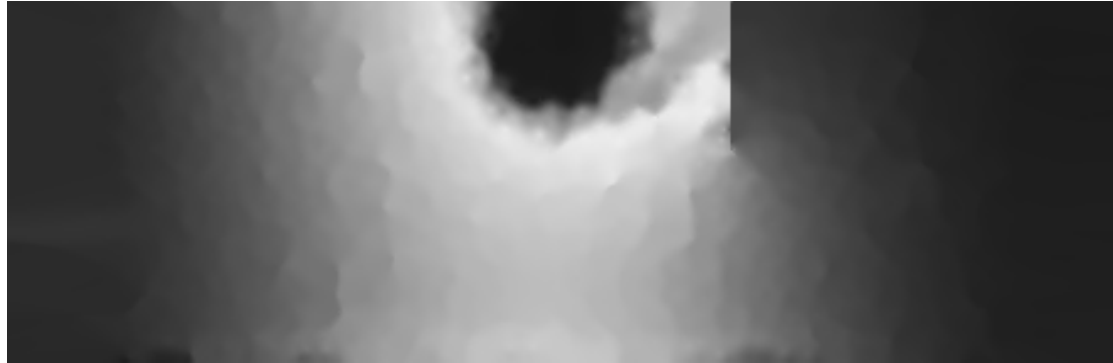
Figure 16. Heat map generated by run (3)